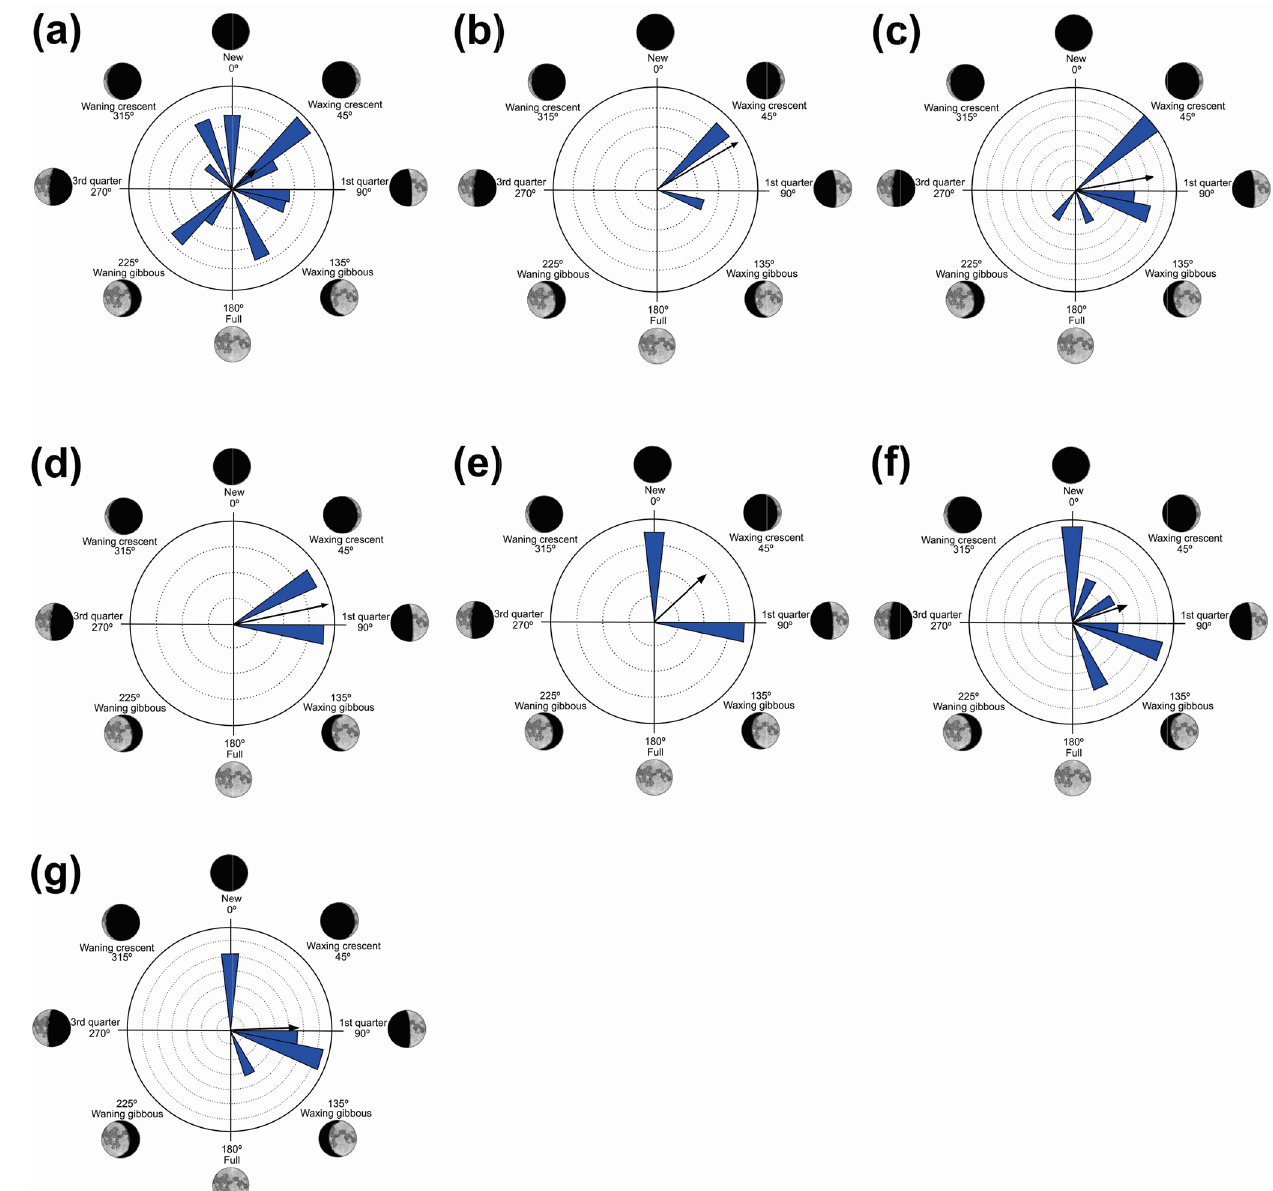
Figure 4. Species with unidirectional behavior in quadrant II of the polar axis (46–134 ◦ ) clockwise, under the influence of the synodic cycle between the waning crescent and waxing gibbous (intermediate albedo): (a) Boana albopunctata , (b) B. pardalis , (c) Leptodactylus latrans , (d) Pseudopaludicola murundu , (e) S . similis , (f) S . fuscomarginatus , and (g) S . squalirostris